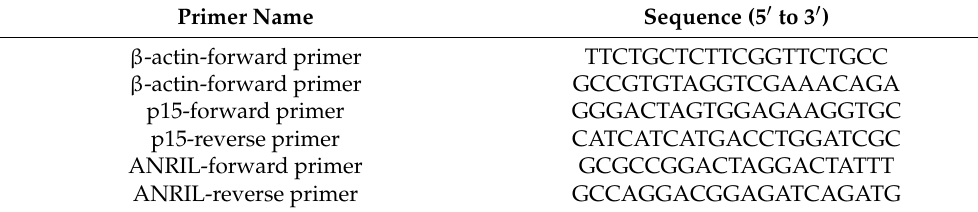
Table 3. Real-time PCR